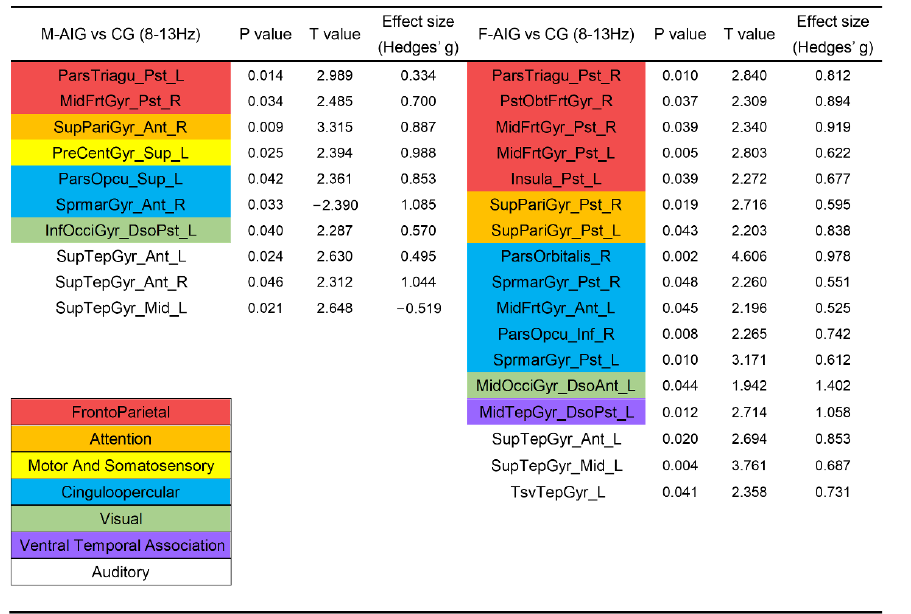
Figure 3. Comparison of ROIs’ activation between M-AIG, F-AIG, and CG in alpha band. M-AIG: male action observation-induced group; F-AIG: female action observation-induced group; CG: con- trol group; L: left, R: right; p < 0.05, FDR corrected (for the full name of ROIs see Supplementary Table S1). Colors for functional modules: red: frontoparietal system; orange: attention system; yel- low: motor and somatosensory system; blue: cinguloopercular system; green: visual system; purple: ventral temporal association; white: auditory system.